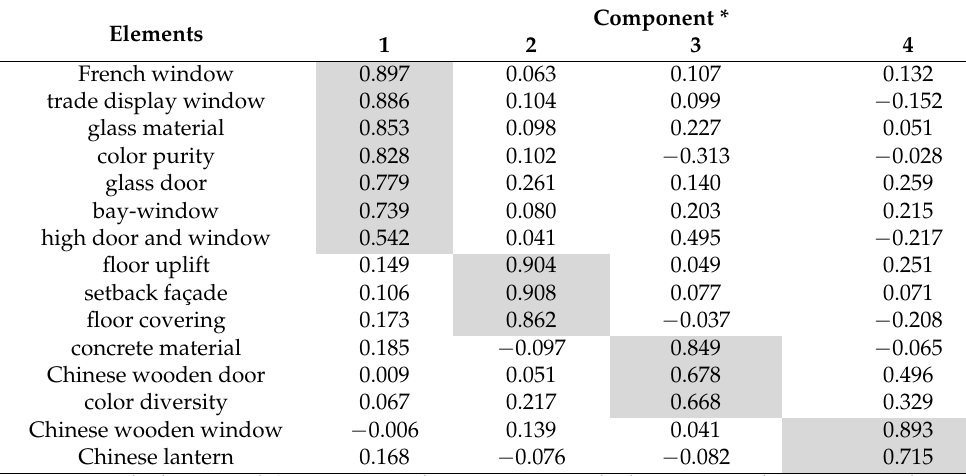
Table 6. Rotated Component Matrix of MiBE.